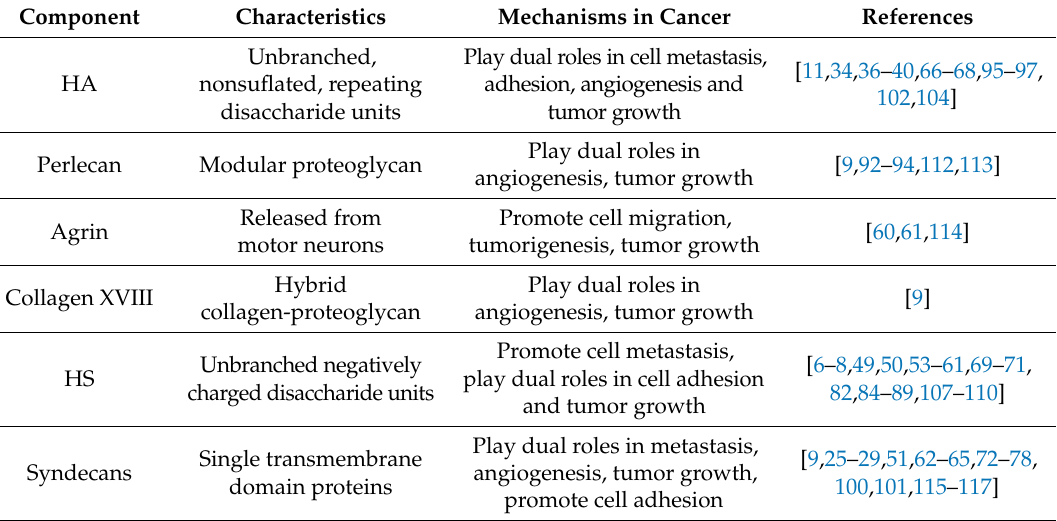
Table 1. Relationship between components of glycocalyx and progression of